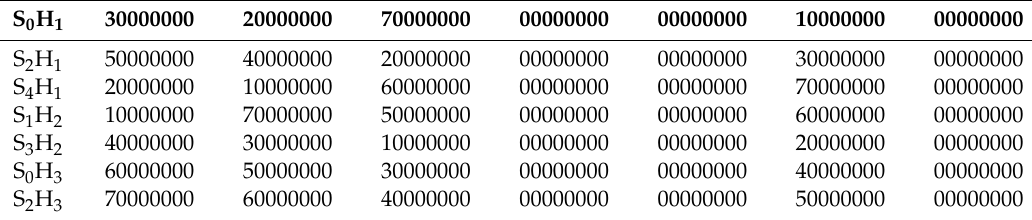
Table 1. Seven 2D-HC sequences with prime number equal to 7.